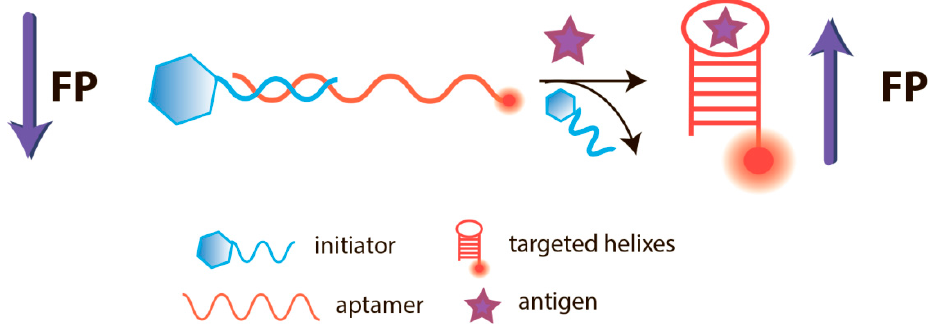
Figure 9. Principle of the switched FP